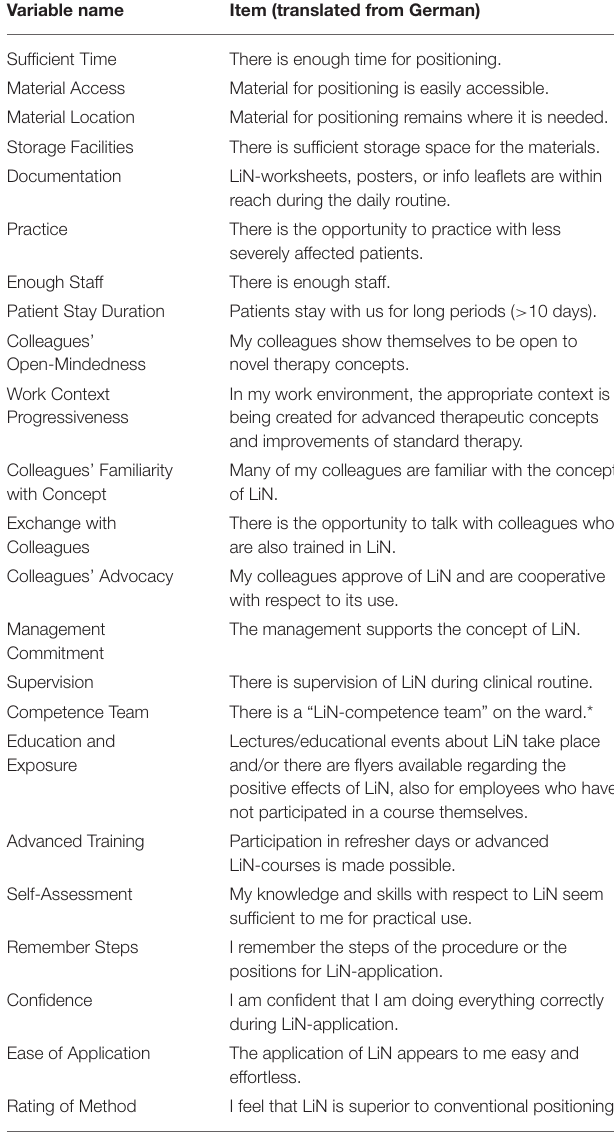
TABLE 1 | Questionnaire of aspects of potential relevance to